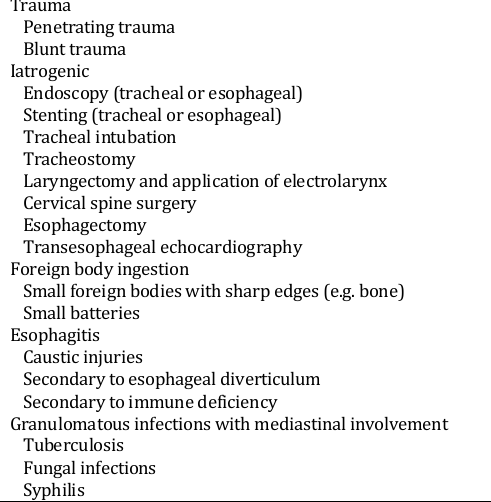
Table 3. Causes of benign acquired tracheoesophageal